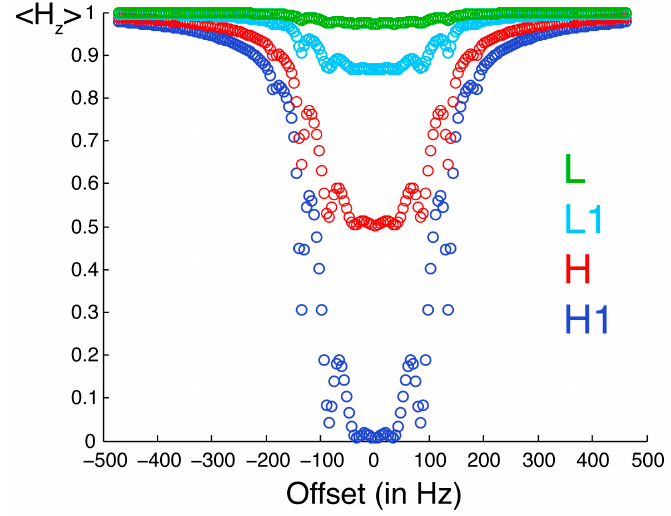
Figure 3. Saturation profiles simulated for the spin system described in Figure 2. The observable longitudinal polarization for proton H1 is shown in dark blue. Equilibrium polarizations are normalized to unity. H1 is the one irradiated by selective radiofrequency pulses. The offset between the resonance frequency of H1 and the carrier frequency of radiofrequency pulses is on the x -axis. The longitudinal polarization of protons H, L1 and L are in red, light blue and green, respectively.